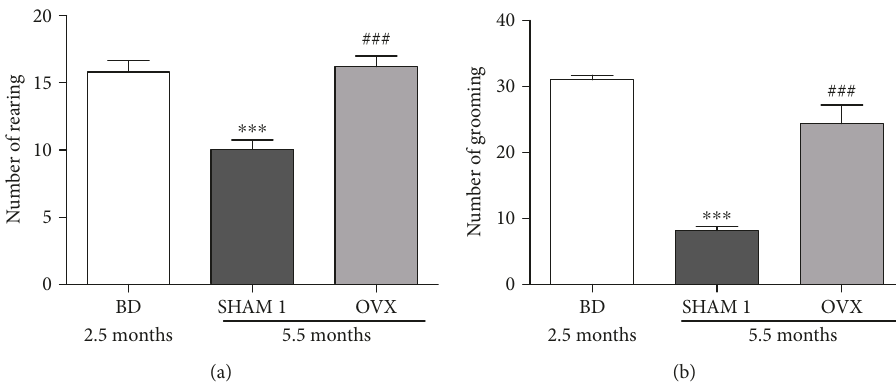
Figure 3: E ff ects of age and ovariectomy on number of rearing (a) and the number of grooming (b) of rats in the Y-maze. OVX =ovariectomized rat aged 5.5 months; BD =nonovariectomized rats aged 2.5 months which served as basic data; SHAM 1=nonovariectomized rats aged 5.5 months. ∗∗∗ p < 0 001 as compared to control BD. ### p < 0 001 as compared to the NOR